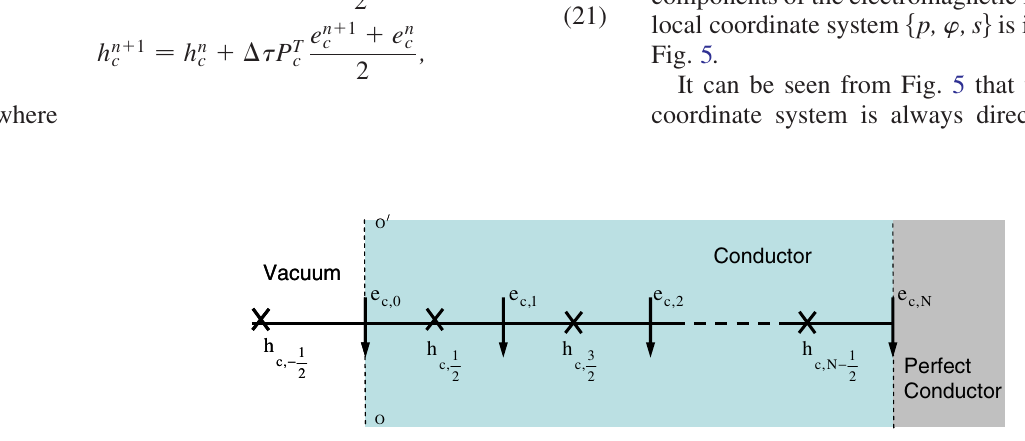
FIG. 4. The line wire discretization in the conductor